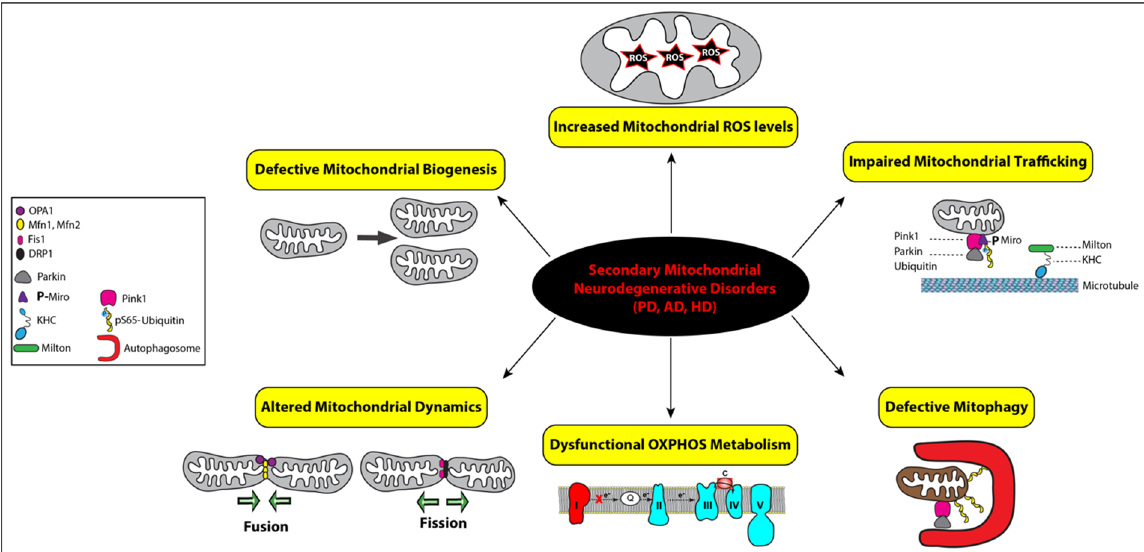
Figure 3. Functional link between mitochondrial dysfunctions and the pathogenesis of secondary mitochondrial neurodegenerative diseases. Mitochondrial homeostasis is regulated by four distinct pathways: biogenesis, dynamics, trafficking, and mitophagy, while mitochondrial bioenergetics is impaired by defective OXPHOS indicated with complex I in red to illustrate its deficiency and increased levels of reactive oxygen species (ROS), represented by a star symbol. The key regulators of mitochondrial fusion (OPA1, Mfn1, and Mfn2) and fission (Fis1 and DRP1) are illustrated with symbols, as detailed in the inset. Impaired mitochondrial trafficking is shown with detached mitochondrion from microtubules via the heavy kinesin chain and the Miro–Milton adaptor complex and ubiquitin. All the corresponding symbols are shown in the inset. Mitophagy is represented with the assistance of autophagosomes (red symbol) engulfing a ubiquitinated mitochondrion that was promoted by Parkin after its recruitment by PINK1 (pink symbol). Mitophagy is impaired in secondary mitochondrial neurodegenerative disorders, Alzheimer’s disease (AD), Parkinson’s disease (PD), and Huntington’s disease